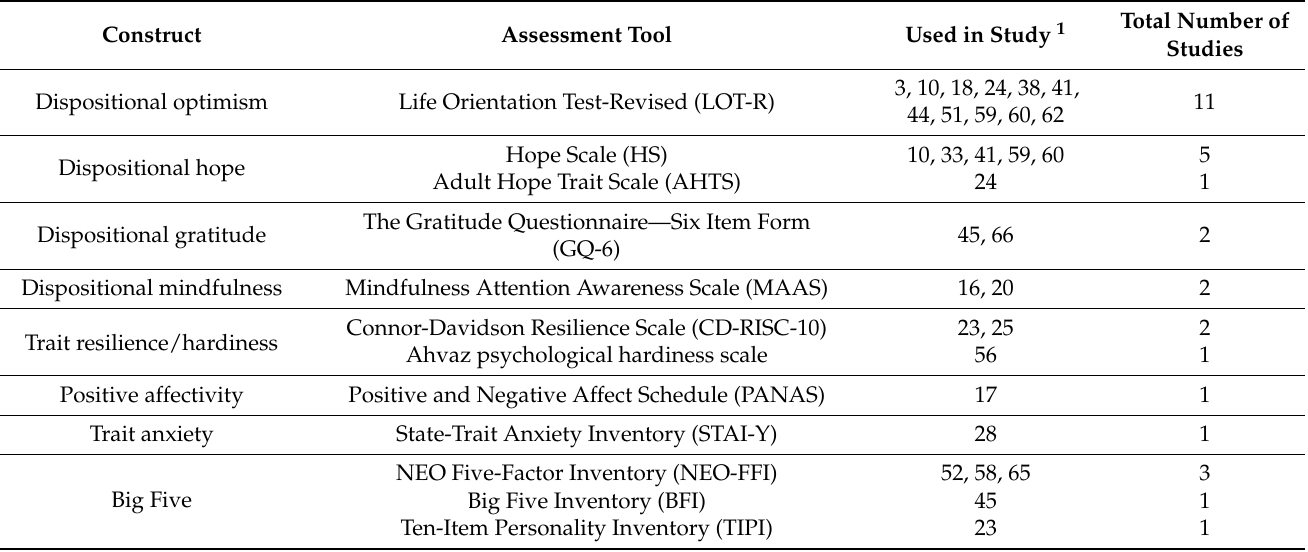
Table 2. Assessment tools for personality (self-report questionnaires).